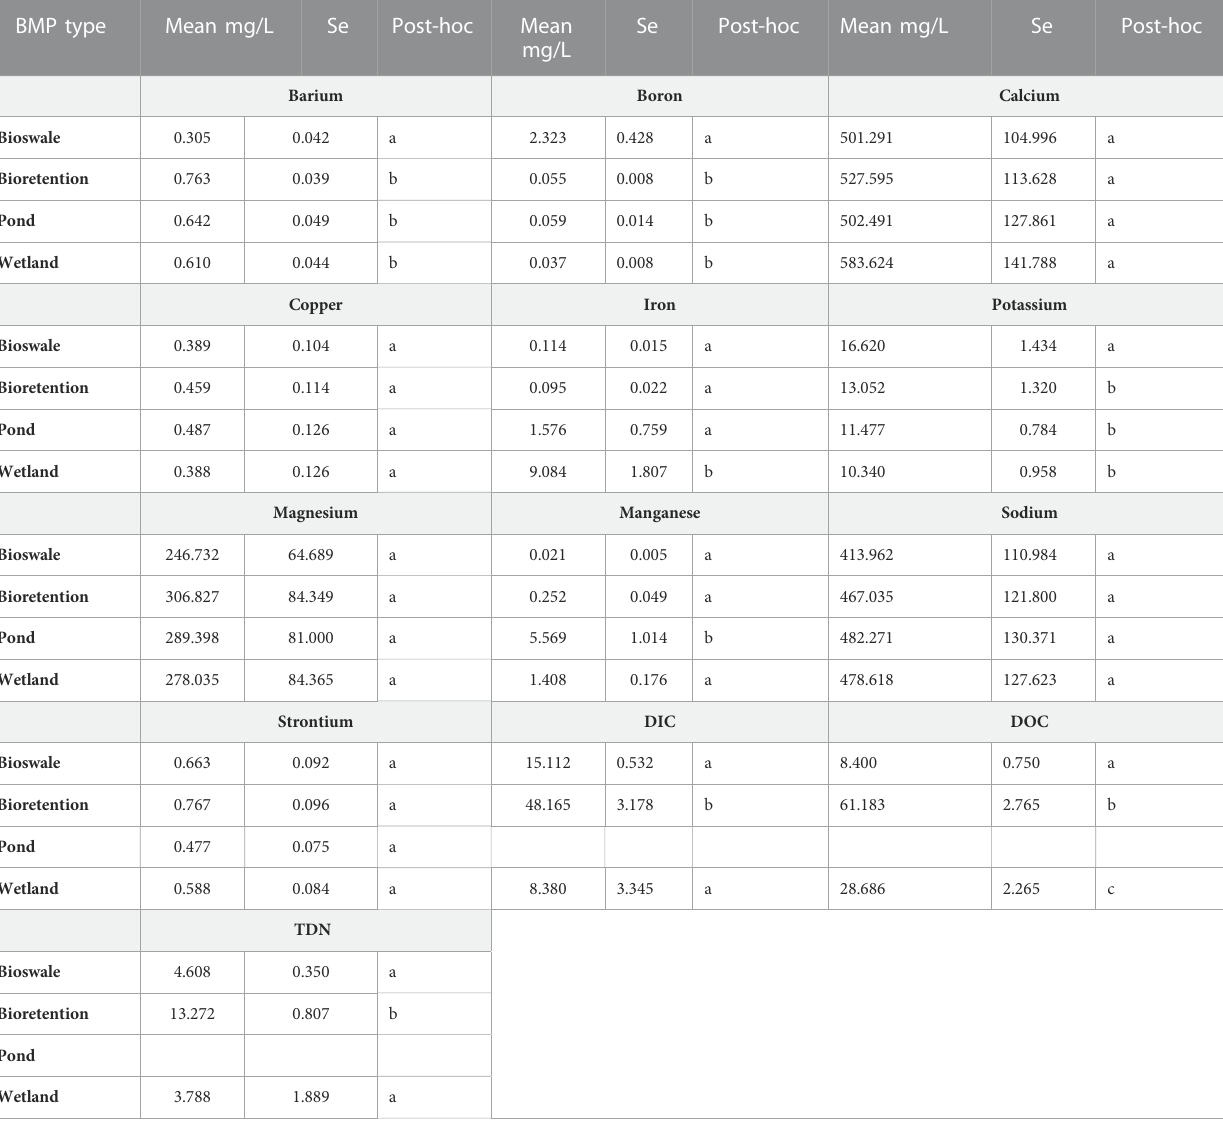
TABLE 5 Tukey ’ s Honestly-Signi fi cant-Difference test was used to make pair-wise comparisons among mean elemental mobilization in the three-way ANOVAs acrossBMPtype(Bioswale,Bioretention,Pond,Wetland).Meanmobilizationratesforagivenmajorortraceelementshareacommonletterinthe posthoc column when they are not statistically different from one another ( p >